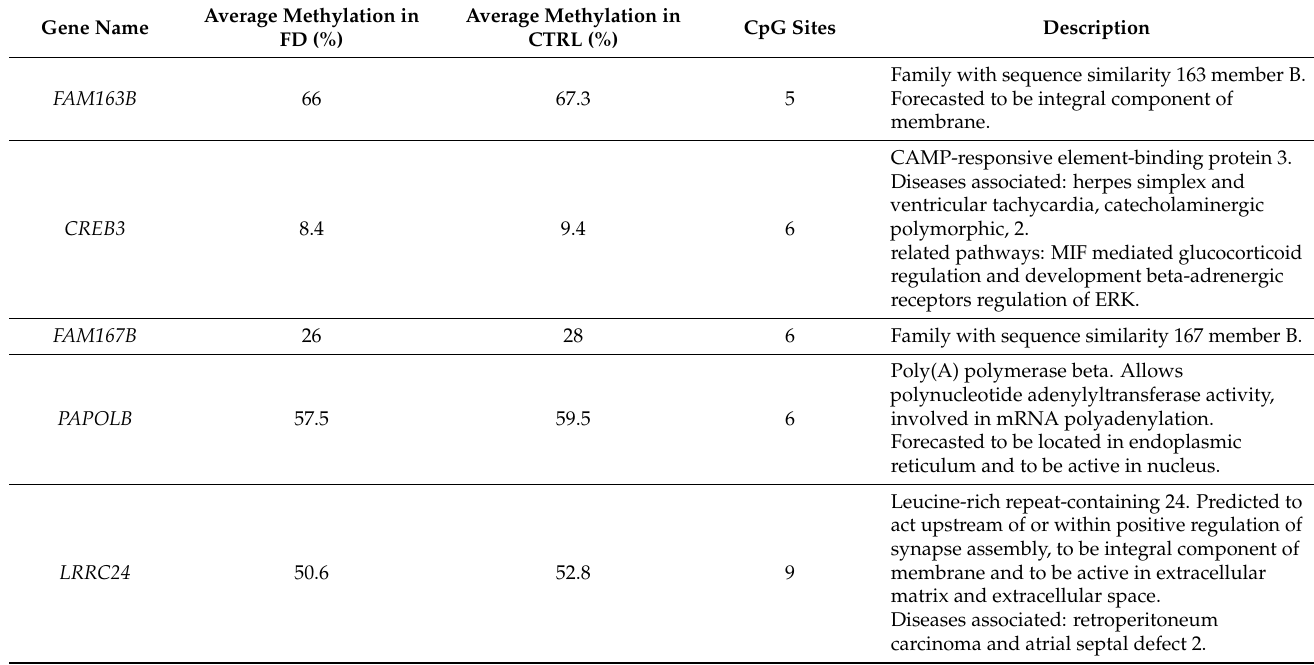
Table 3. Differentially methylated genes with low degree of methylation in